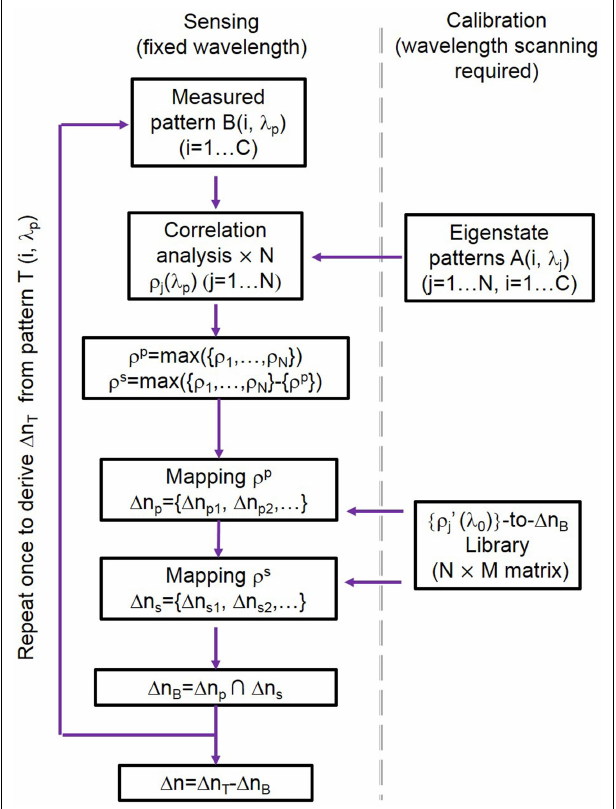
FIGURE 2 | A flow chart showing the sensing algorithm including calibration of CROW-based sensors .